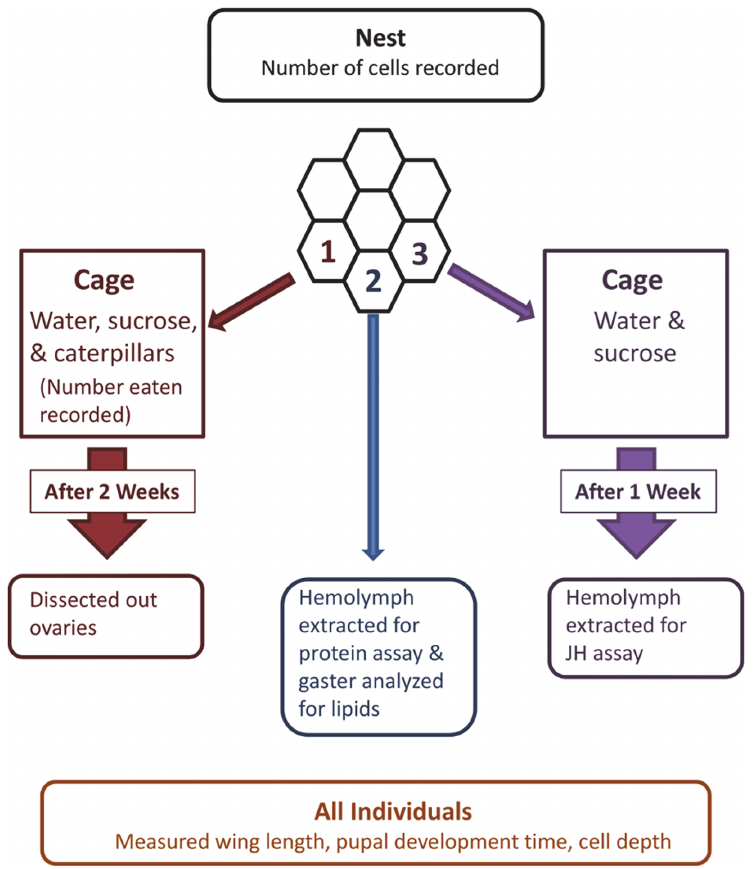
Fig 1. Depiction of the treatment of newly-emerged wasps during the experiment. The first emerged individual was reared in a cage for two weeks with a caterpillar supplement. After two weeks the ovaries were dissected. The second individual was frozen immediately after emergence and the levels of hemolymph protein and gaster lipids were measured. The third individual was reared for one week after eclosion and then the hemolymph was extracted for JH measurements. (The JH results were removed from the main analysis due to small sample sizes but are reported in the supplement.). This order was repeated until the end of the